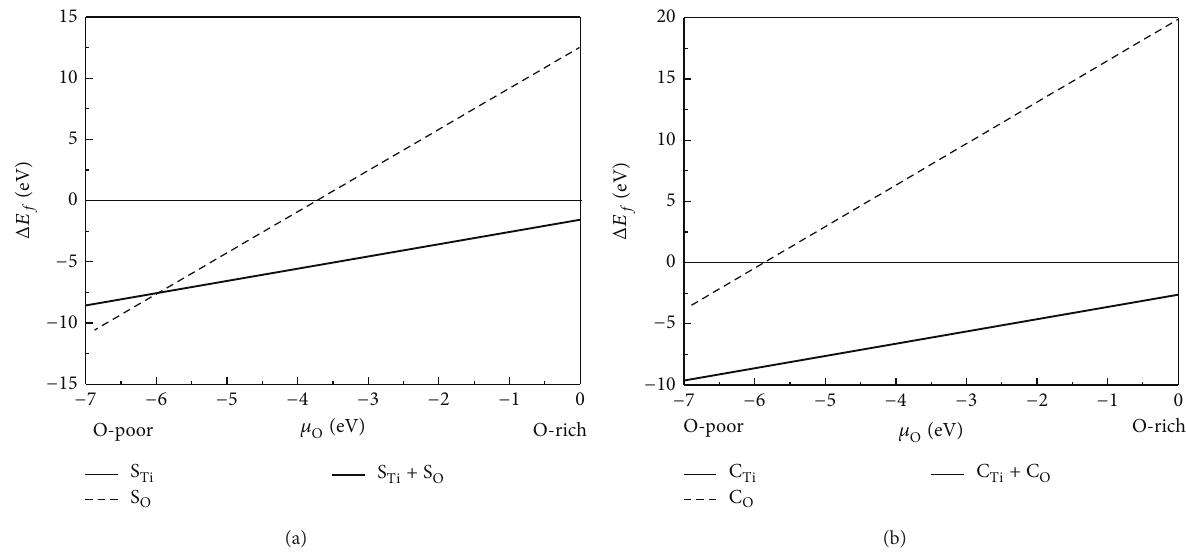
+ S complexes as a function of O chemical potential. The zero in the vertical axis Ti O + C complexes as a function of O chemical Ti O